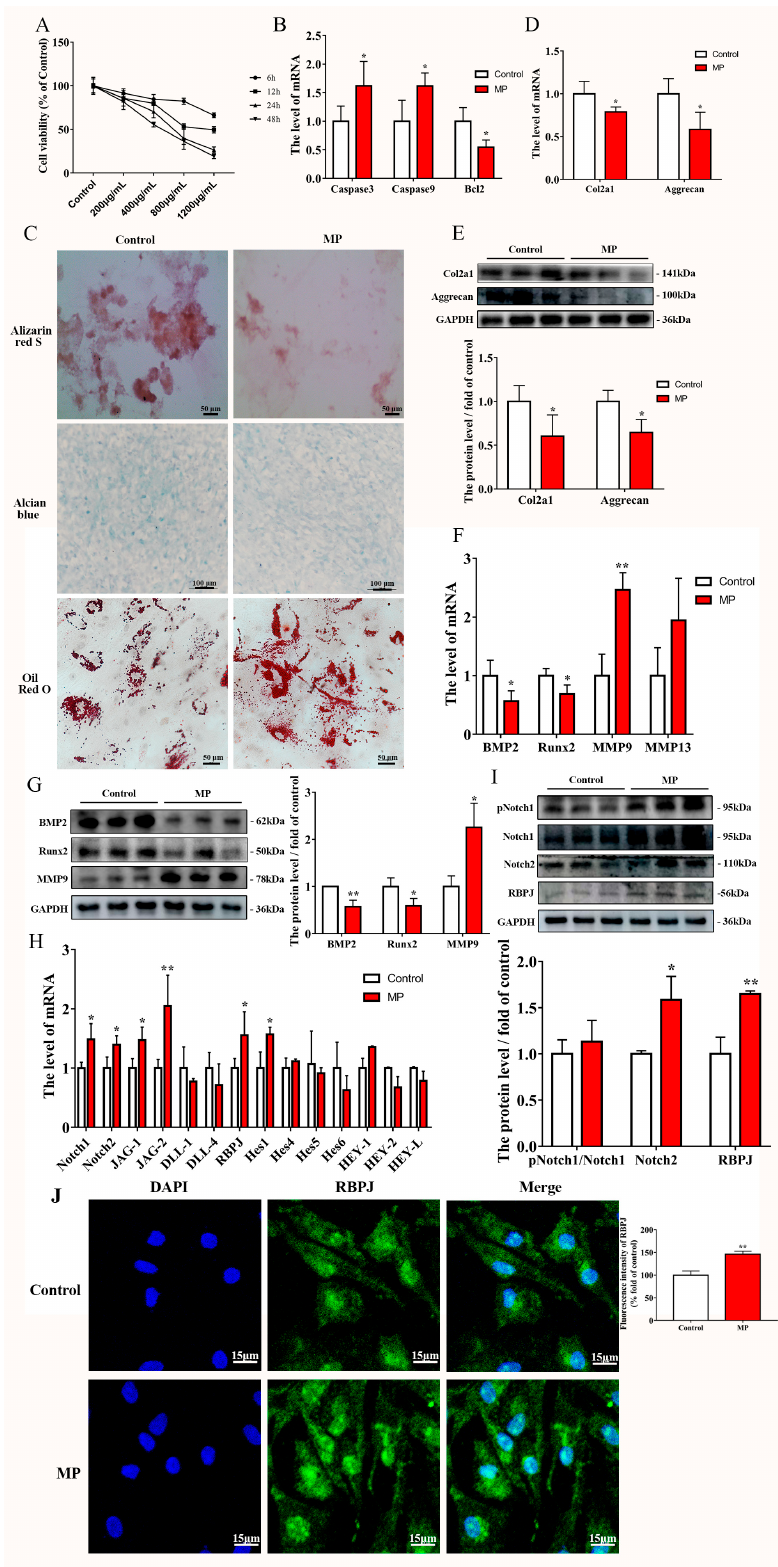
Figure 2. MP exposure activated the notch pathway in BMSCs. ( A ) The cell viability of